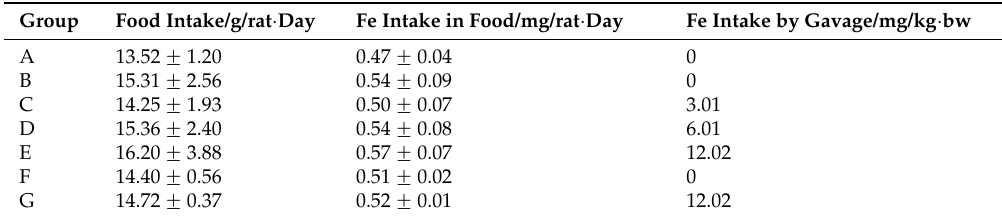
Table 4. Fe intake of rats.